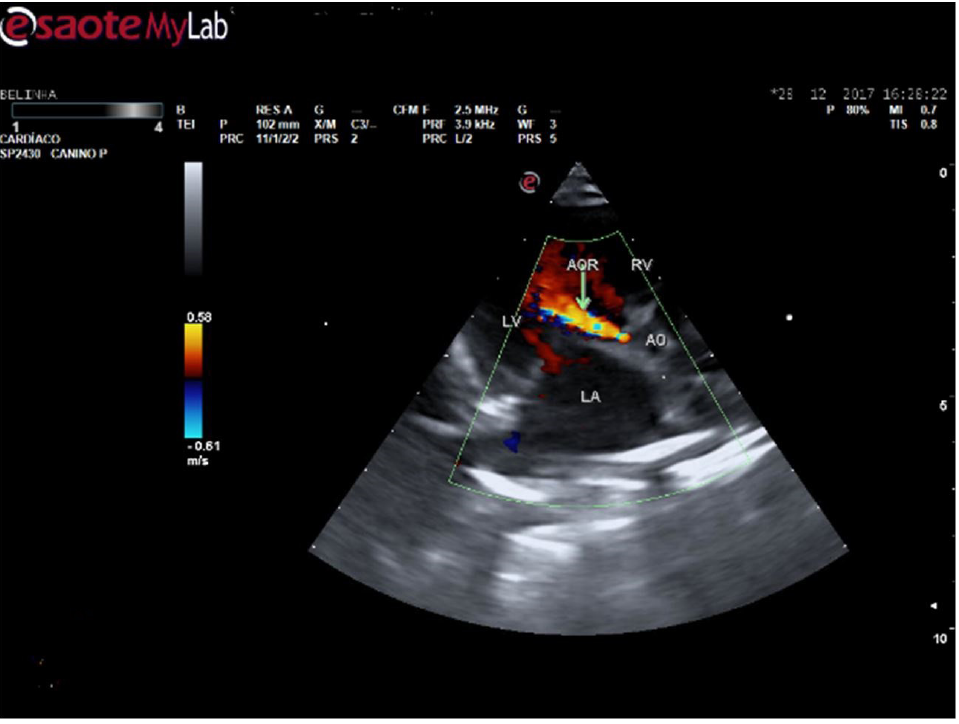
Figure 5. Color flow mapping shows aortic insufficiency (AOR) but no more mitral diastolic reflux after restoration of sinus rhythm. LV = left ventricle; RV = right ventricle; AOR = atrium aorta ratio; LA = left atrium; AO= aorta.